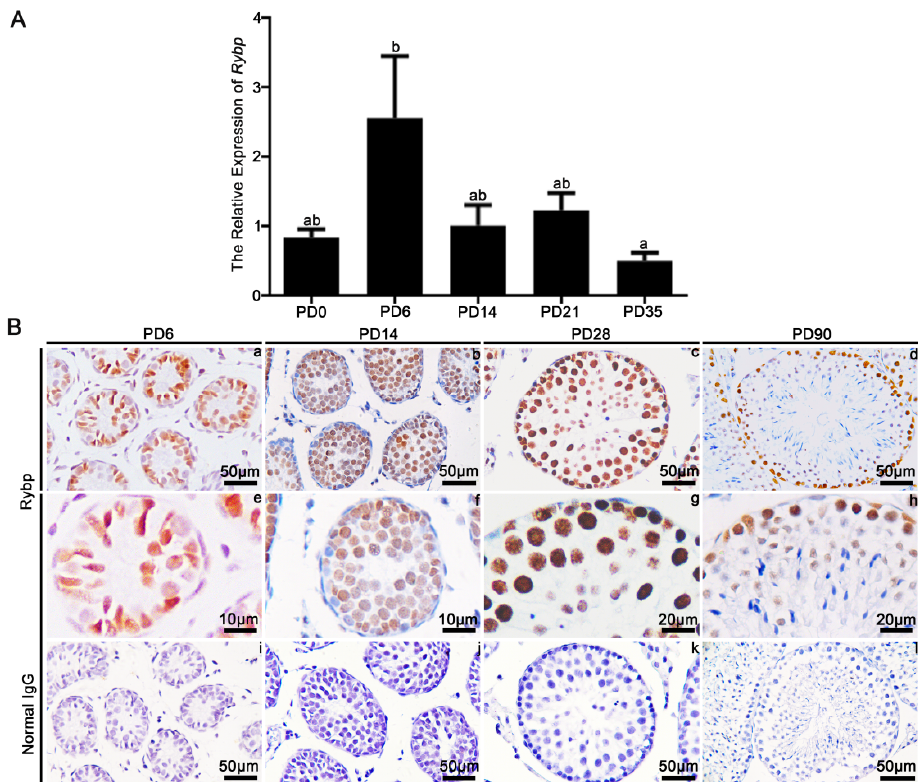
Figure 1. Relative mRNA expression and protein localization of Ring 1 and YY1 binding protein (Rybp) in murine testes. ( A ) Quantification of Rybp mRNA expression in murine testes at different stages of development. Data were analyzed using mean ± SEM for three mice per stage. Values bearing different superscripts significantly differed with p < 0.05. ( B ) Immunohistochemical staining of Rybp in murine testes at different stages of development. Scale bar: a–d and i–l, 50 μm; e and f, 10 μm; g and h, 20 μm.